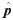
Estimated per-capita rates of origination p^ and extinction q^.Rates are from (A) NEW insect family data and (B) Labandeira [11].